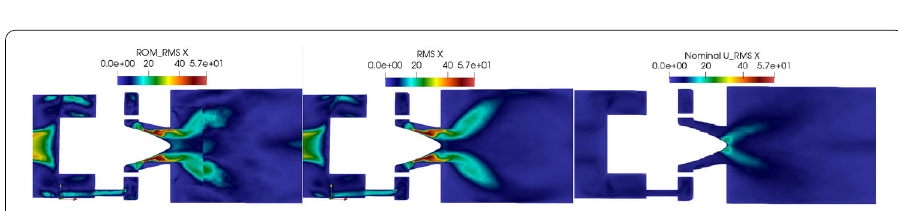
Fig. 43 On the left, the third component of the mean flow field by the UGPOD applied to configuration 1. In the middle, the third component of the high fidelity mean flow field with configuration 1. On the right, the third component of the high fidelity mean flow field with the nominal configuration